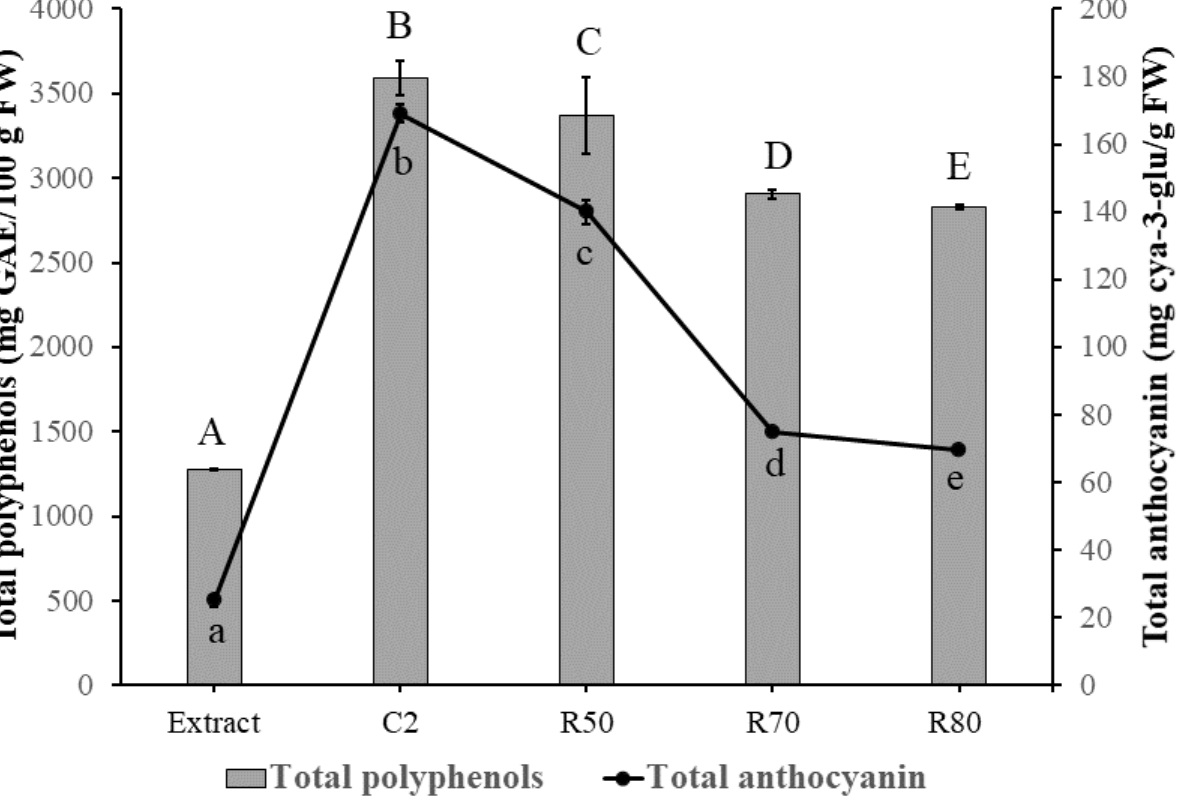
Figure 2. Total polyphenol (mg GAE/100 g FW) and Total anthocyanin (mg cya-3-glu/g FW) content in extract and maqui concentrates. C: cryoconcentrate; concentrates by evaporation at 50 °C (R50), 70 °C (R70), and 80 °C (R80). Different capital letters over the bars indicate a significant difference ( p ≤ 0.05 for total polyphenol content) and different low letters